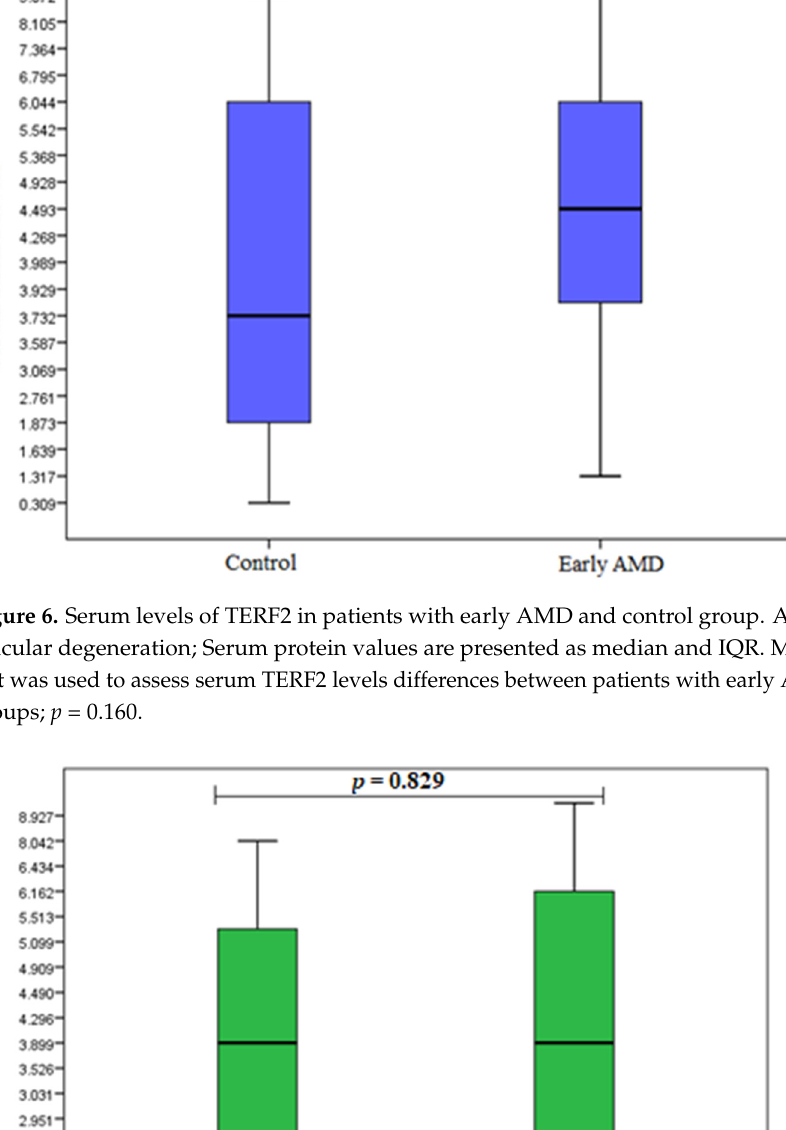
Figure 5. Serum levels of TERF1 in patients with exudative AMD and control group. AMD: age- related macular degeneration; Serum protein values are presented as median and IQR. Mann–Whit- ney U test was used to assess serum TERF1 levels differences between patients with exudative AMD and control groups; p = 0.607.